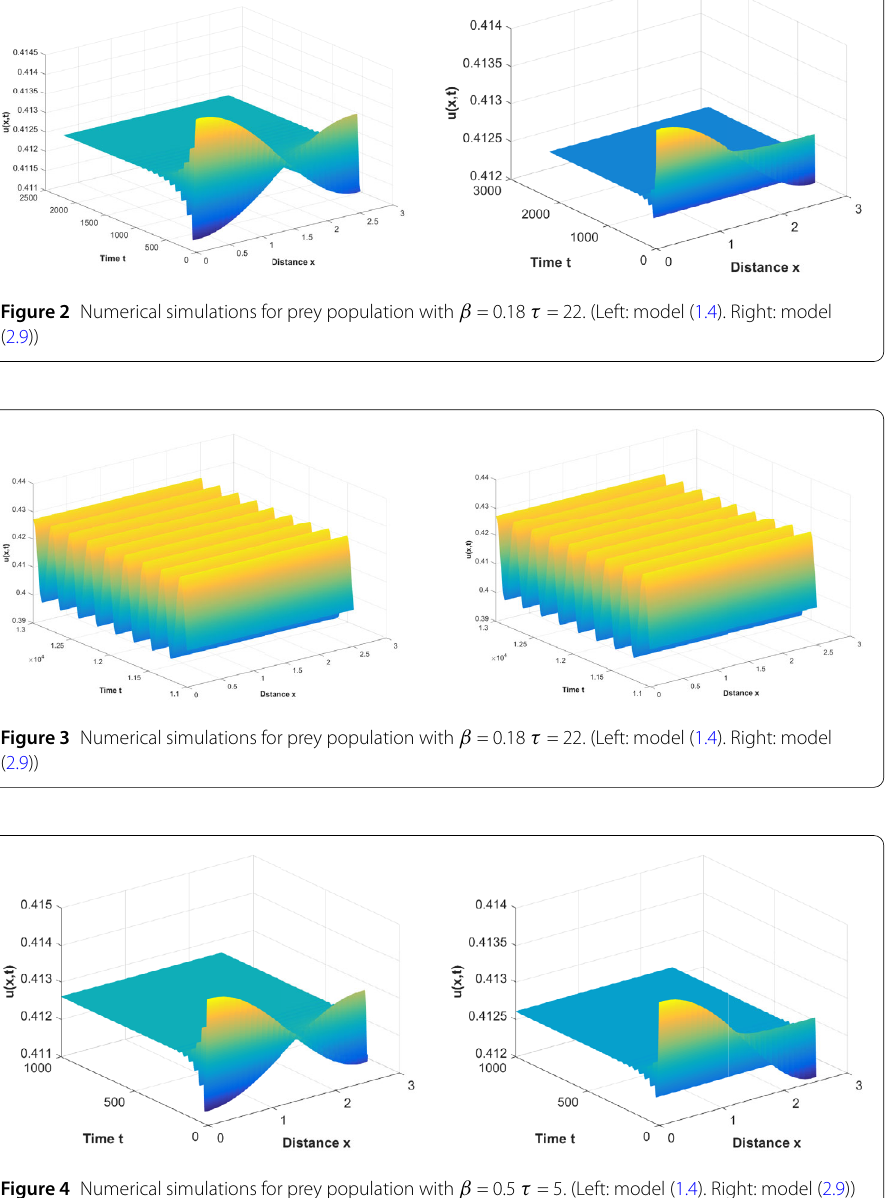
stable (Fig. 5 right). When τ > τ 0